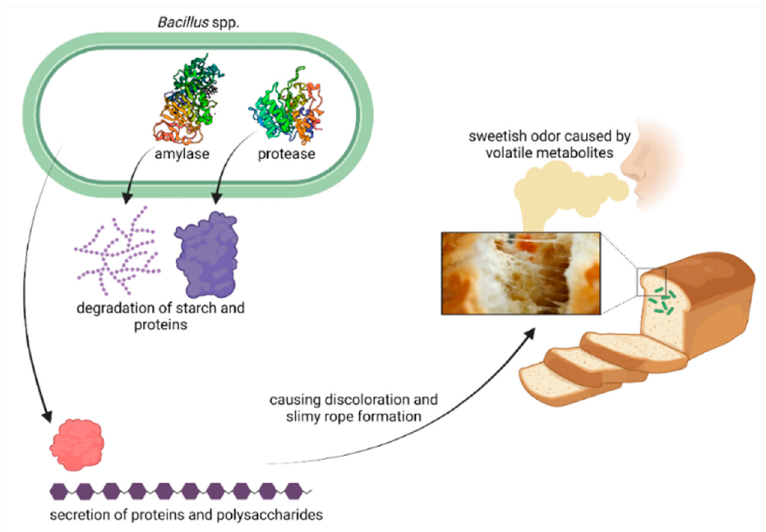
Figure 1. Mechanisms of rope formation, discoloration, odor development, and changes in bread structure. Created with